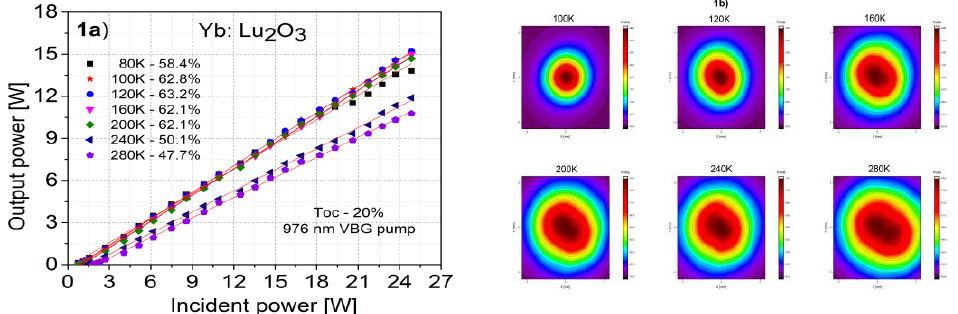
Fig. 1 (a) Input - Output power characteristics of 1. at.% Yb:Lu 2 O 3 ceramic at different temperatures,T OC = 20%; (b) Obtained beam profile for different temperatures at maximum